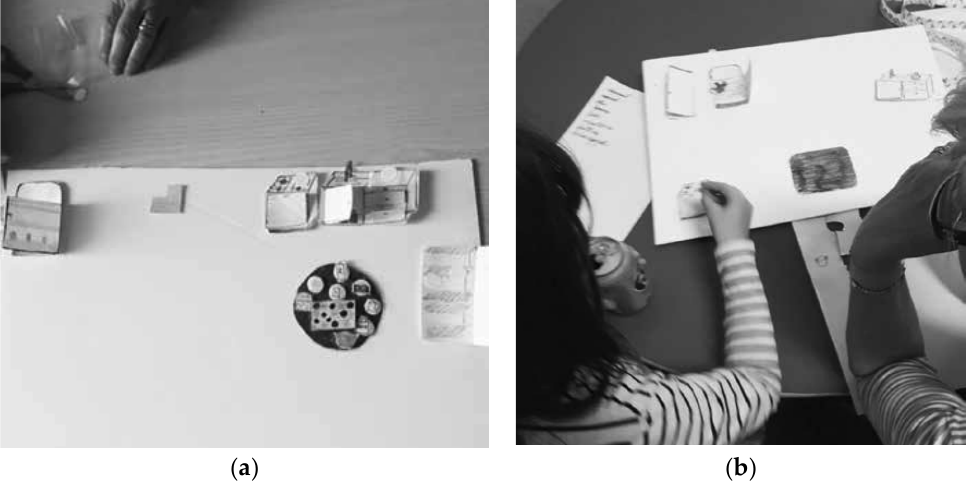
Figure 2. The second evaluation consisting in the action on the represented task. ( a ) The cooking of the biscuits realized with the icons by J., ( b ) B. reconstructing the procedure of cooking spaghetti.